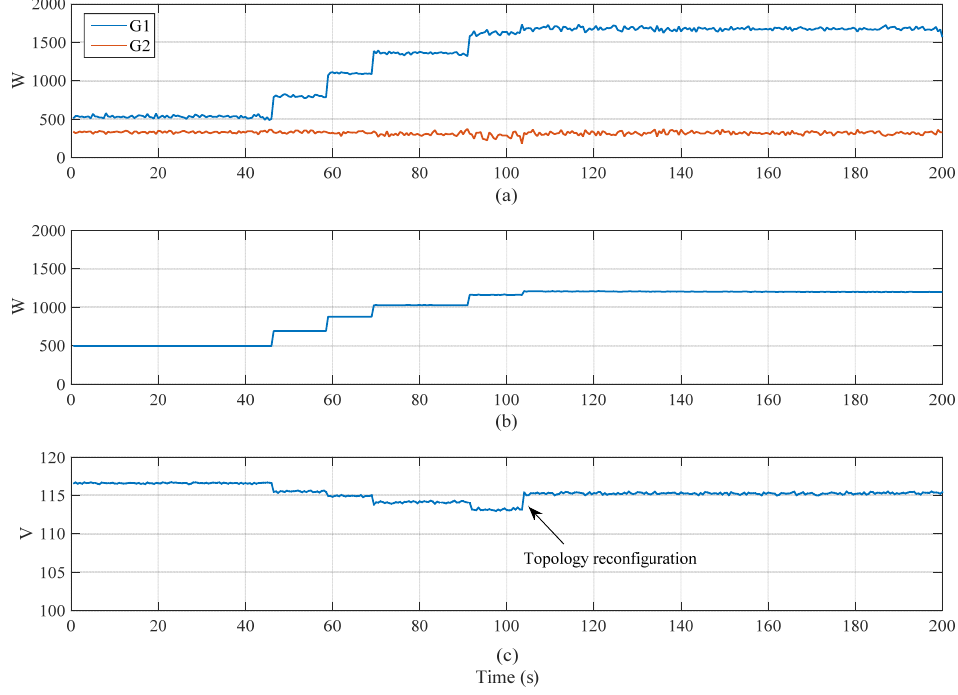
Figure 19. Case 3, topology reconfiguration. ( a ) Output power of generators 1 and 2; ( b ) load 4 power; and ( c ) load 4 voltage.